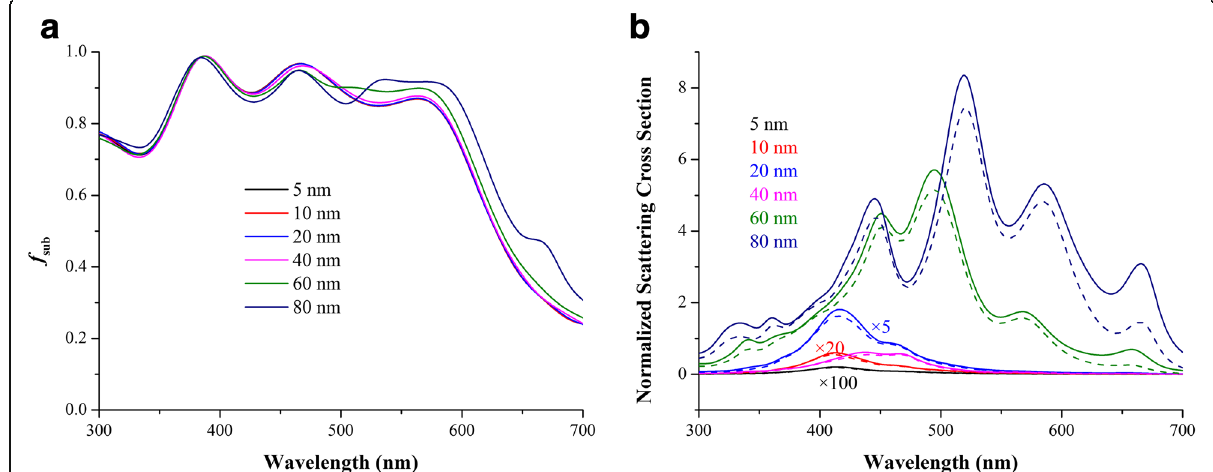
Fig. 4 a The fraction of light scattered into the active layer with Al cathode presenting. b Total scattering cross section (solid) and cross section for light scattered into the substrate (dashed line) with Al cathode presenting, all normalized to geometrical cross sections